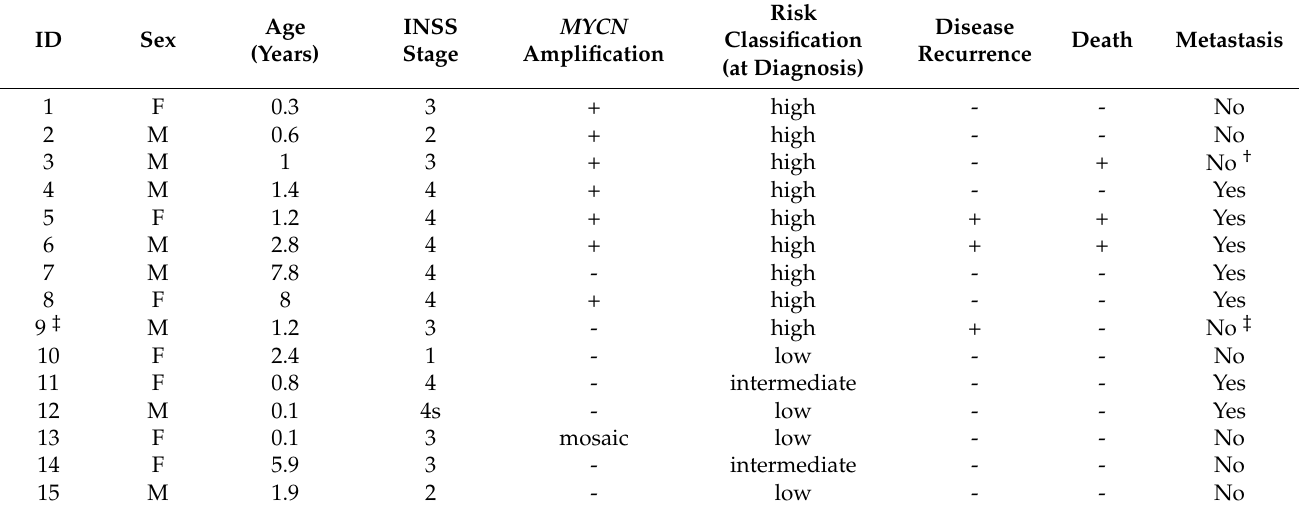
Table 3. Clinicopathological characteristics for our patient